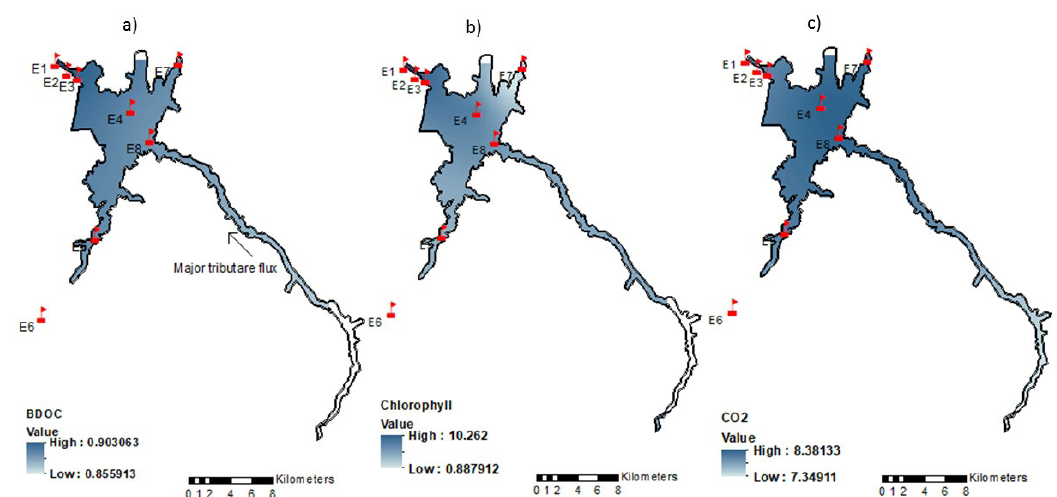
Figure 3. Spatial predictions using Kriging method for the distribution of a) Biodegradable Dissolved Organic Carbon (BDOC) b) Chlorophyll and c) Carbon Dioxide (CO BDOC will be generated in areas close to the center of the reservoir (E4). Close to the dam (E1, E2, E3) will produce high values of BDOC and chlorophyll and low levels of CO and Chlorophyll are predicted in the major tributary area (E5, E6,